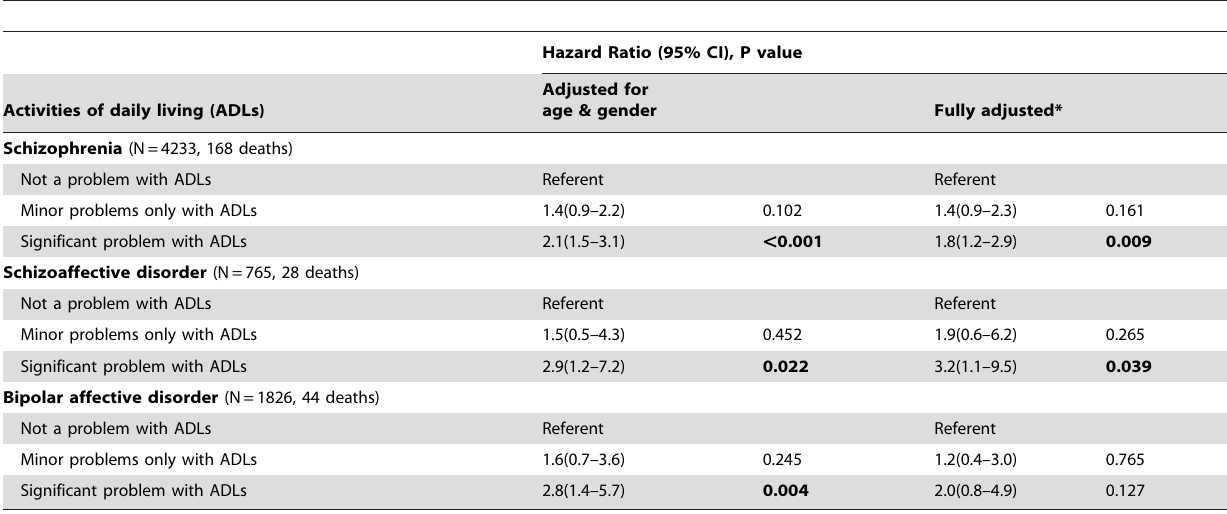
Table 5. Association between activities of daily living (ADLs) and all-cause mortality in individuals with serious mental illness stratified by